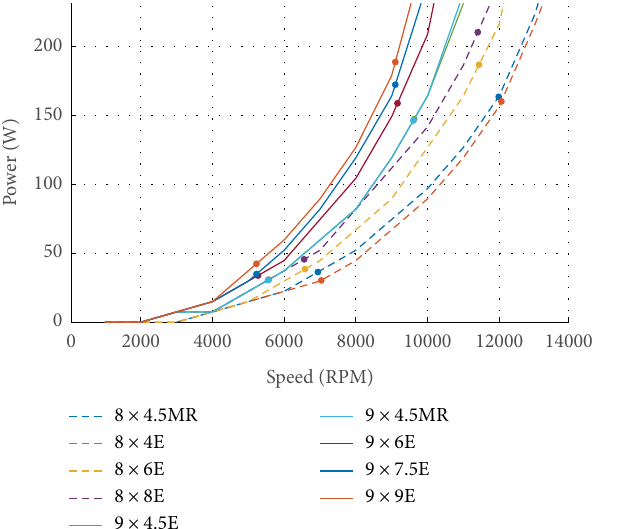
Figure 10: Comparison of power–speed characteristics of 8 and 9 inch propellers.